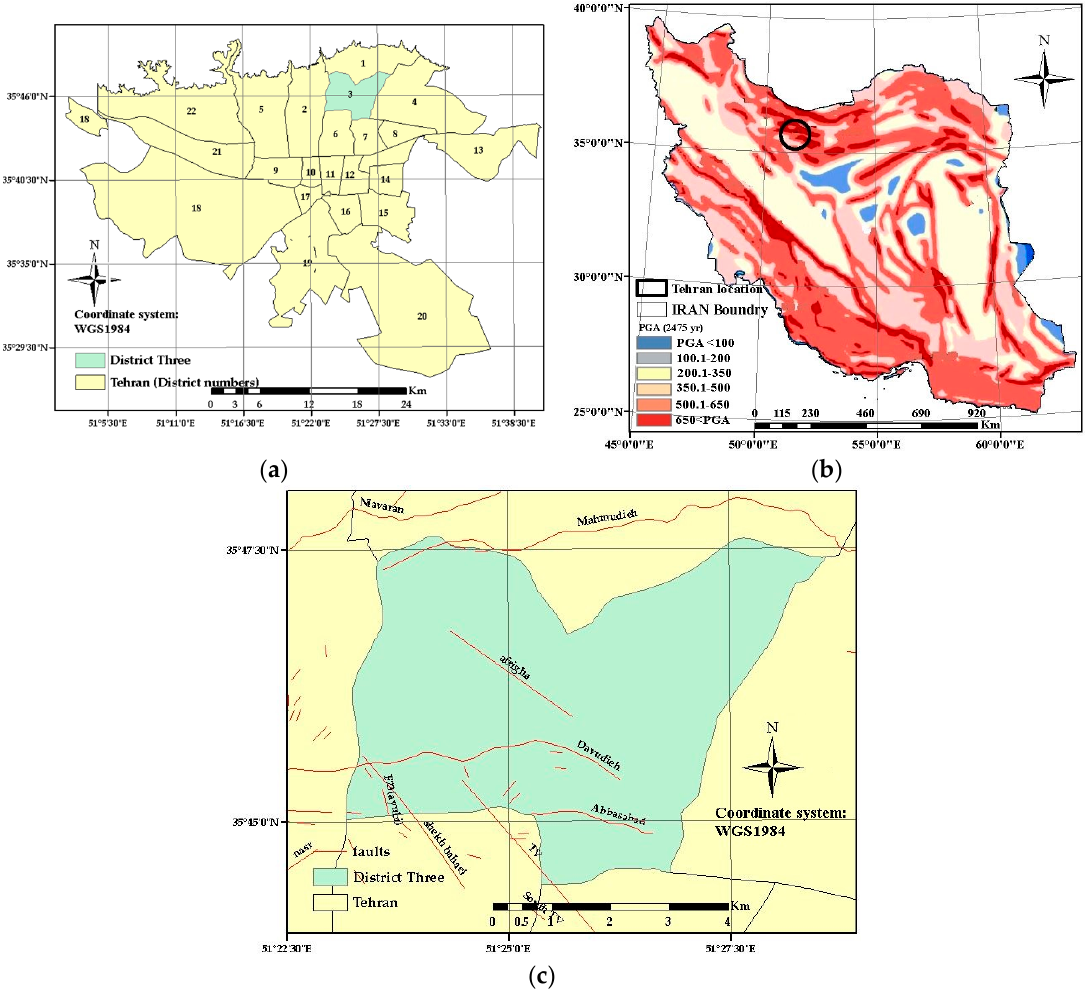
Figure 1. Location of case study: ( a ) location of District 3, Tehran, ( b ) peak ground acceleration map of Iran for a return period of 2475 years [36] and approximate location of Tehran, ( c ) location of faults in District Three of Tehran.